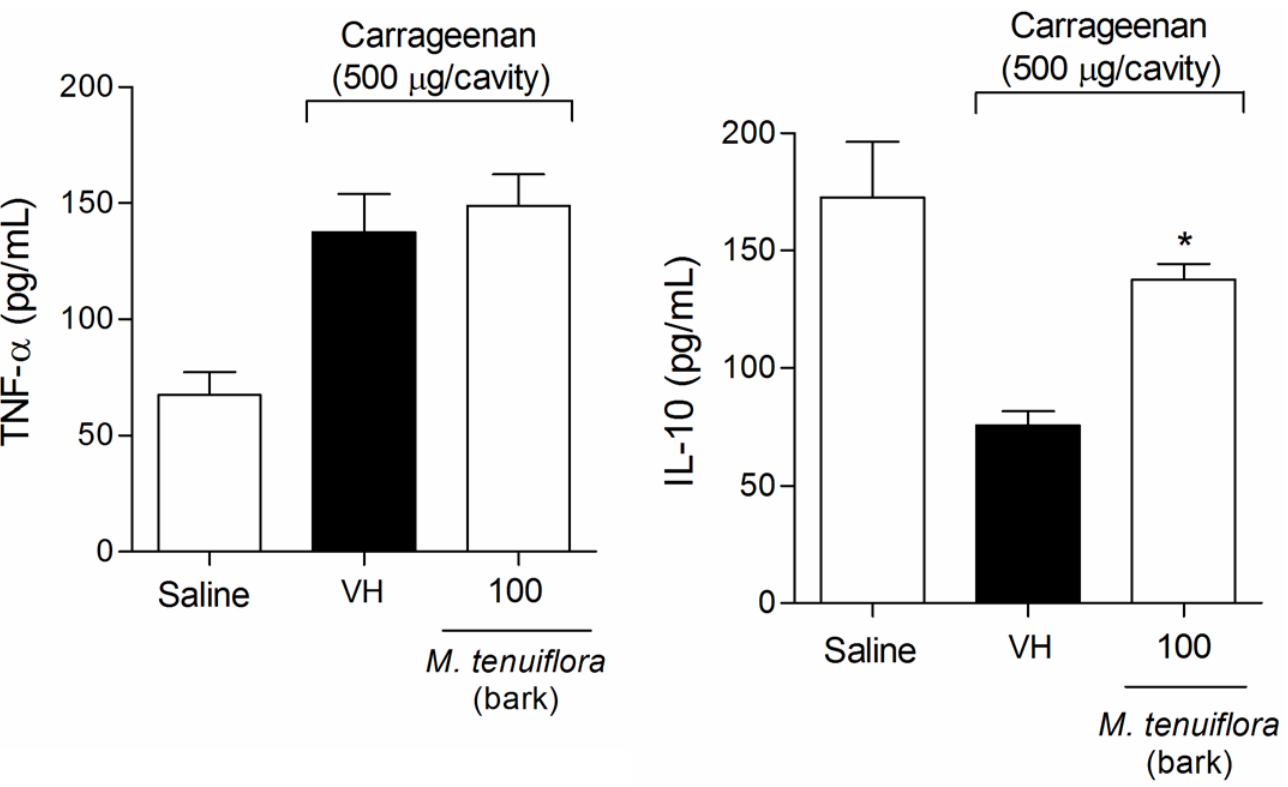
Fig 8. Effect of the ethanolic extract of M . tenuiflora bark on Cg-induced TNF- α (A) and IL-10 (B) production in the peritoneal exudate. VH is the vehicle group (negative control). The ethanol extract of M . tenuiflora bark was tested at a dose of 100 mg/kg (s.c.). The results are presented as the mean ± S.D. (n = 8). Statistical significance was calculated by ANOVA followed by Bonferroni's test. * P < 0.05 compared to the vehicle-negative control treated